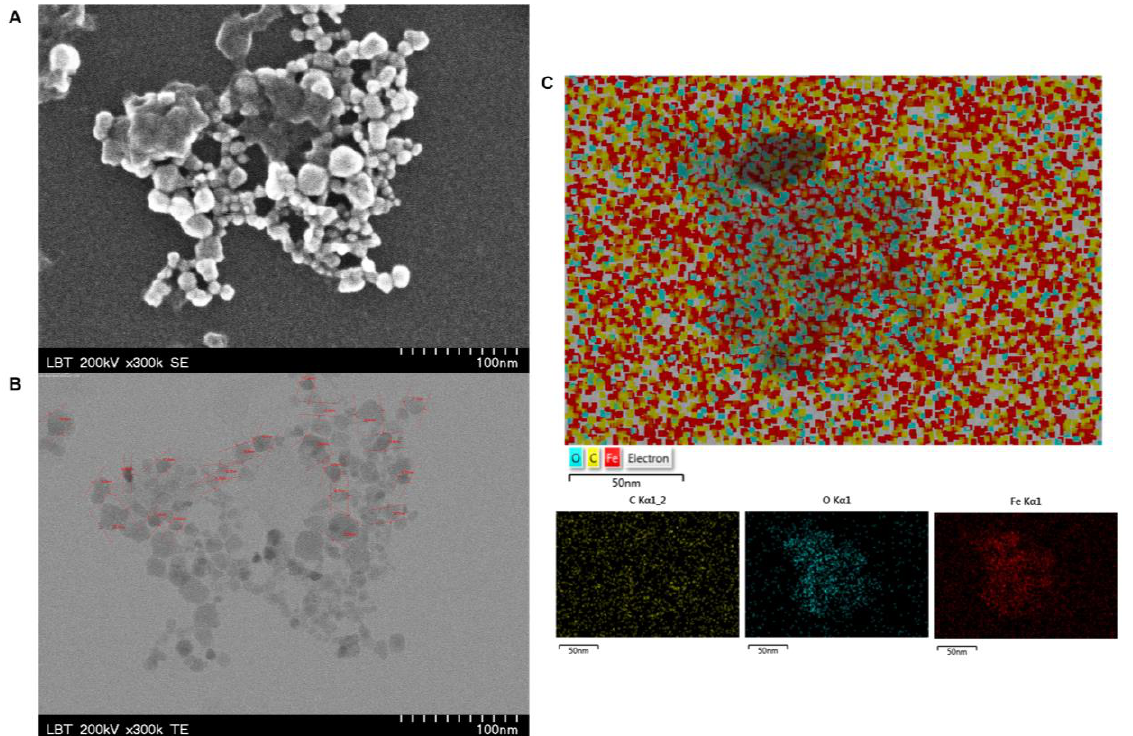
Figure 7. SEM ( A ) and TEM ( B ) images at higher magnifications for details/measurements, and an EDX map ( C ) analysis of MCS.